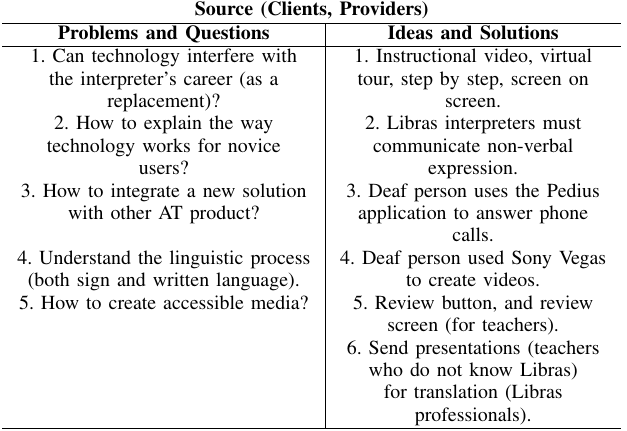
TABLE V E VALUATION F RAME RESULTS FOR THE M ARKET LAYER